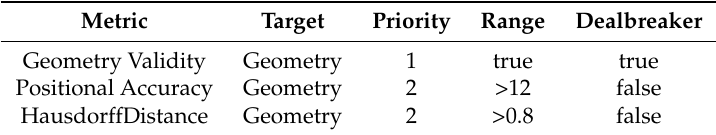
Table 7. Road Network Requirement Profile: A road network is well-defined if the road network geometries are valid, the positional accuracy of the road network is greater than 12 decimals and a HausdorffDistance so bigger than 0.8 to a reference dataset.